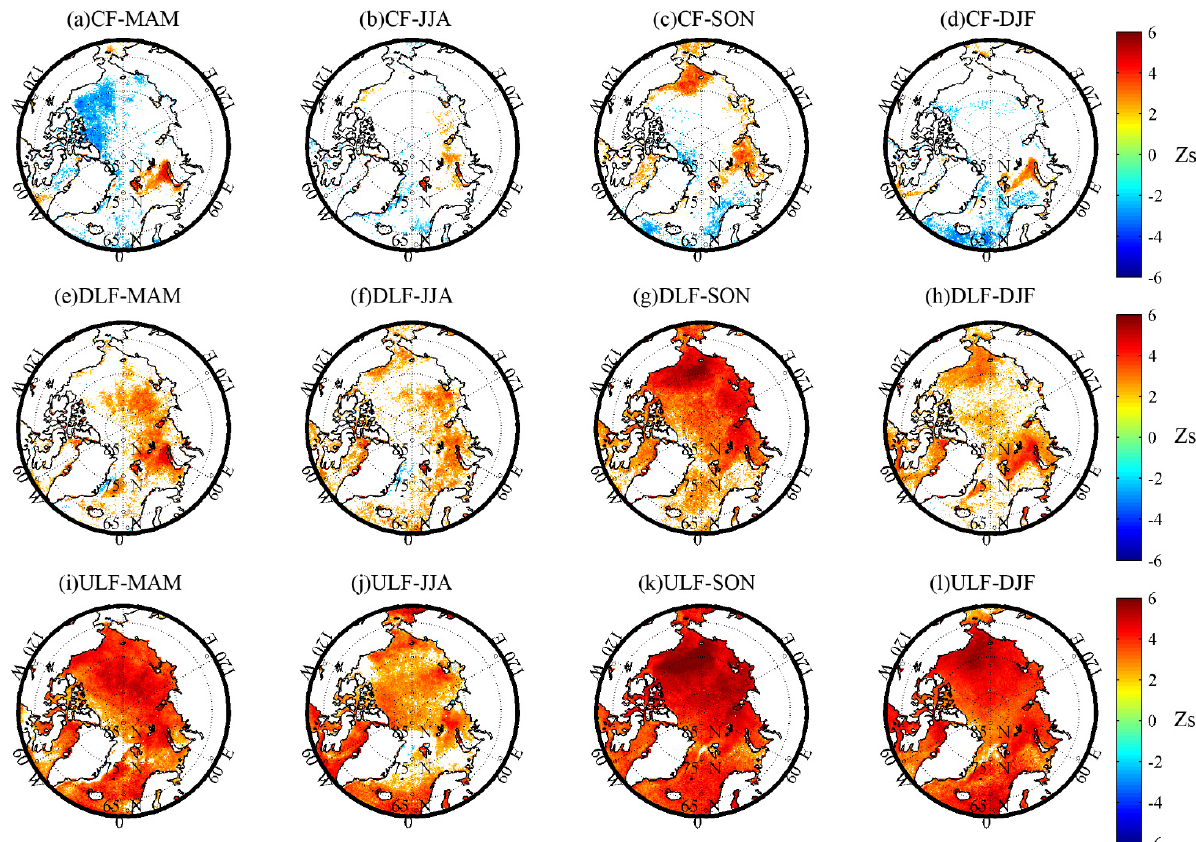
Figure 5. Spatial distributions of Z s derived by the Mann–Kendall test over the seas in Arctic (60°~90°N) for different seasons from 1982 to 2019 at 04:00 LST. ( a – d ) CF in MAM, JJA, SON, and DJF. ( e – h ) DLF in MAM, JJA, SON, and DJF. ( i – l ) ULF in MAM, JJA, SON, and DJF. The colored regions are at a significance level of 95%. Different from the spatial distributions of seasonal CF trend, the positive trends of the DLF and ULF are very obvious almost over the entire Arctic seas for all seasons. More- over, the positive trends for both ULF and DLF are more significant in autumn and rela- tively weaker in summer. Compared with the DLF, the ULF has a more significant posi- tive trend. The spatial distribution of the trend in spring here is similar as the findings from Huang et al. [27]. They found that for the regions between the central Arctic Ocean and the coasts of Russia, the DLF increased every year from March to mid-May from 2000 to 2015 [27]. Moreover, the ULF showed similar spatial variations as DLF. Note that the CF, DLF, and ULF have the similar trend in some regions and certain seasons. For example, over the regions close to the eastern coast of Greenland, the CF and DLF present a relatively clear negative trend in MAM and JJA. Over the Baffin Bay, Chuk- chi Sea, and Kara Sea, the CF, DLF, and ULF display a significant positive trend in SON. Additionally, in other seasons and regions, the CF, DLF, and ULF have the opposite trends. For example, during MAM, over the Chukchi and Beaufort Seas, the CF and DLF present a negative or slightly positive trend, while the ULF shows a strong positive trend. The results derived by the Sen’s slope statistical test are displayed in Figure 6. The value of β indicates the magnitude of the trends. The dataset is the same as Figure 5. In general, the variation magnitude of CF is small. Only for some regions in the particular season, the trends are relatively significant. For example, the positive magnitudes of the CF over the Kara and Barents Seas are relatively larger in MAM and DJF than those in JJA and SON. Compared with Figure 5, the areas with positive CF trend also show a higher magnitude in SON, such as the East Siberian, Chukchi, and Beaufort Seas. For the DLF